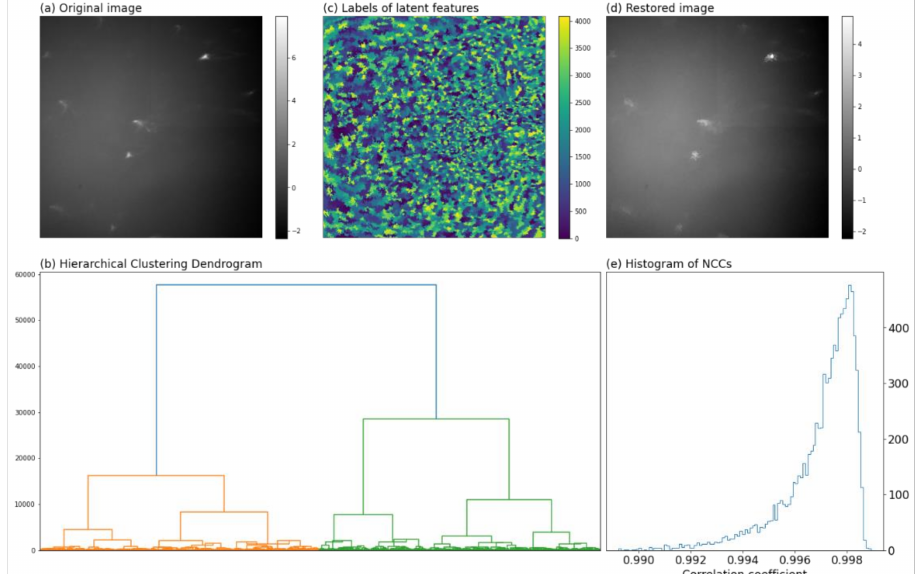
Figure 2. ( a ) One example of diffraction patterns after normalization and 2 × 2 averaging binning; ( b ) hierarchical clustering dendrogram of pixels for feature extraction; ( c ) the distribution of latent features colored by their labels; ( d ) image restored from the latent features; ( e ) histogram of